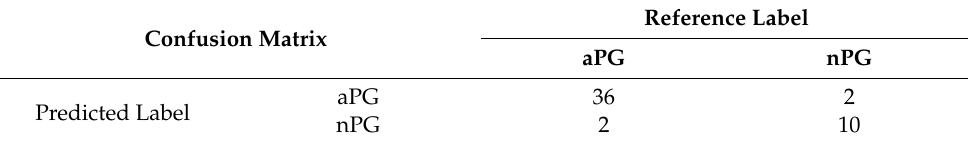
Table 5. Confusion matrix of the ablation